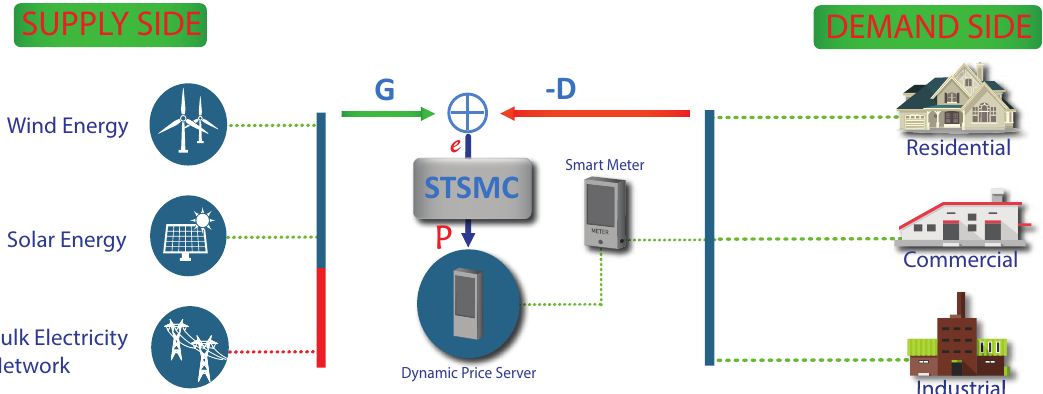
Figure 5. Schematic diagram for the proposed system model to control the elastic demand of consumers through dynamic pricing in a smart